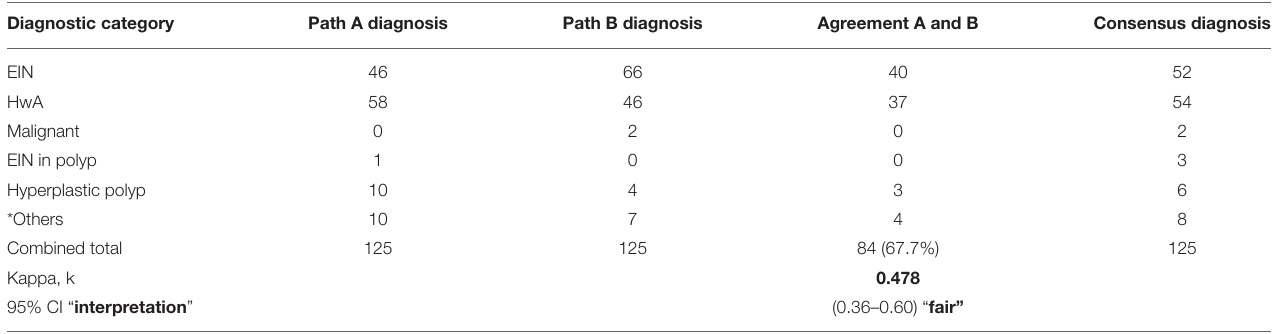
TABLE 2 | Interobserver agreement with diagnosing endometrial hyperplasia using the EIN/WHO 2014 classification. Diagnostic